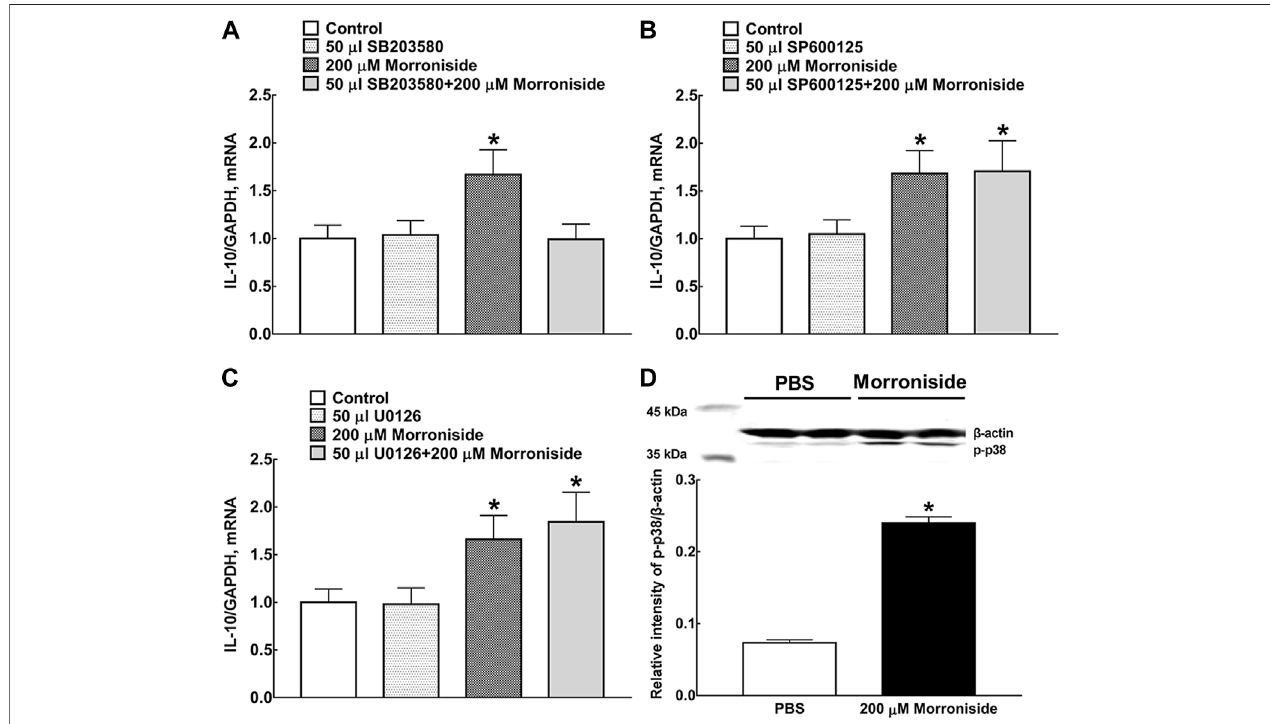
FIGURE3| Effectsoftheselectivep38MAPKinhibitorSB203580 (A) ,JNKMAPKinhibitorSP600125 (B) ,andERK1/2MAPKinhibitorU0126 (C) onmorroniside- inducedIL-10mRNAexpressioninprimary microglia. (D) Effectofmorronisideonp38MAPK phosphorylation inprimary microglia. TheMAPKinhibitors wereincubated 1 h before morroniside treatment. The culture medium and primary microglial cells were collected 2 h after morroniside incubation. Subsequently, the mRNA level of IL- 10wasdeterminedbyRT-qPCR.Thecellularexperimentswererepeatedtriplyandalldatawerepresentedasmeans ± SEM( n (cid:2) 3).* p < 0.05,signi fi cantlydifferent from control group; # p < 0.05, signi fi cantly different from morroniside group; unpaired and two-tailed Student t